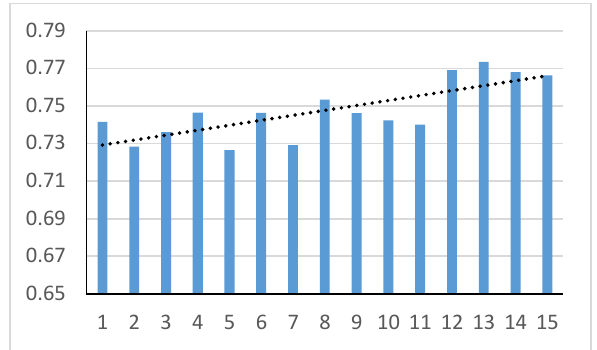
Figure 6. Vegetation change from 2001 to 2015 of Fujian